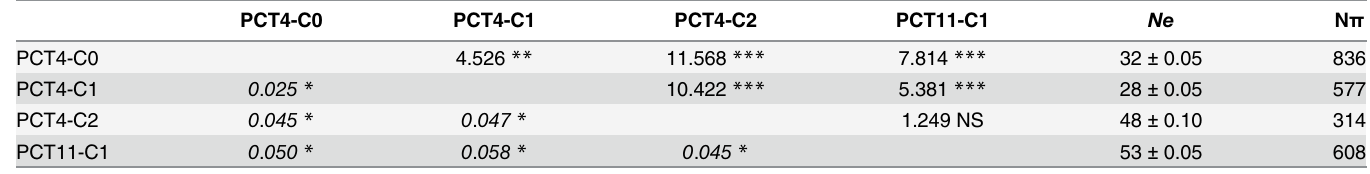
Table 2. Pairwise Fisher distance ( F D ) and genetic differentiation ( F ST ) between subpopulations, effective population size ( Ne ) and number of monomorphic loci for each subpopulation (N π ) out of 3,675 SNP.